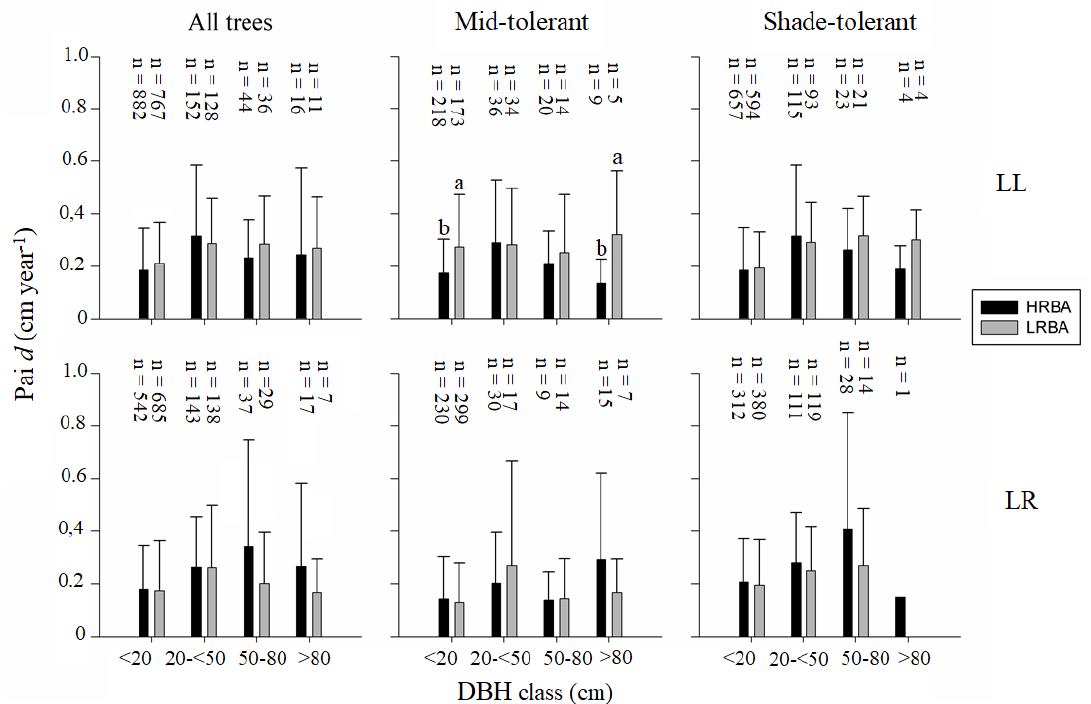
Figure 2. Mean (bars) and standard deviation (whiskers) in pai in d (cm year − 1 ) according to treatment (HRBA, LRBA), site (LL, LR), DBH CLASS ( < 20 cm; 20–50 cm; 50–80 cm; > 80 cm), and functional group. Different letters between bars of the same DBH class show significant differences (value of p < 0.05).